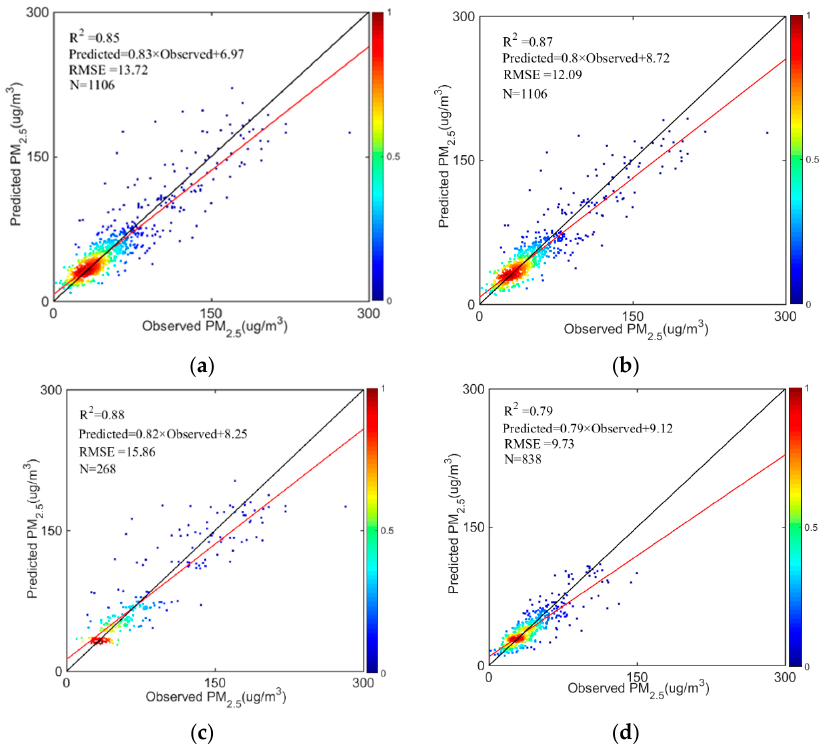
Figure 6. Scatter plot of cross-validated values in Model I and Model II. ( a ) is Model I CV result to overall data; ( b ) is Model II CV result to overall data; ( c ) is Model II CV result to cold season data; ( d ) is Model II CV result to overall data. The black line shows the 1:1 line as a reference, the red line shows the regression line. Table 2. Describing statistical model fitting and CV results (Sit number = 17).